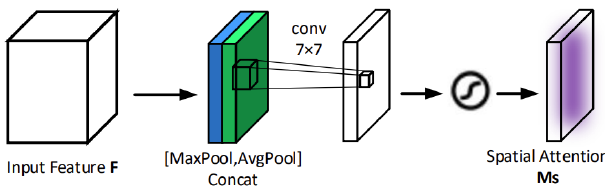
Figure 4. Network structure of the SAM.